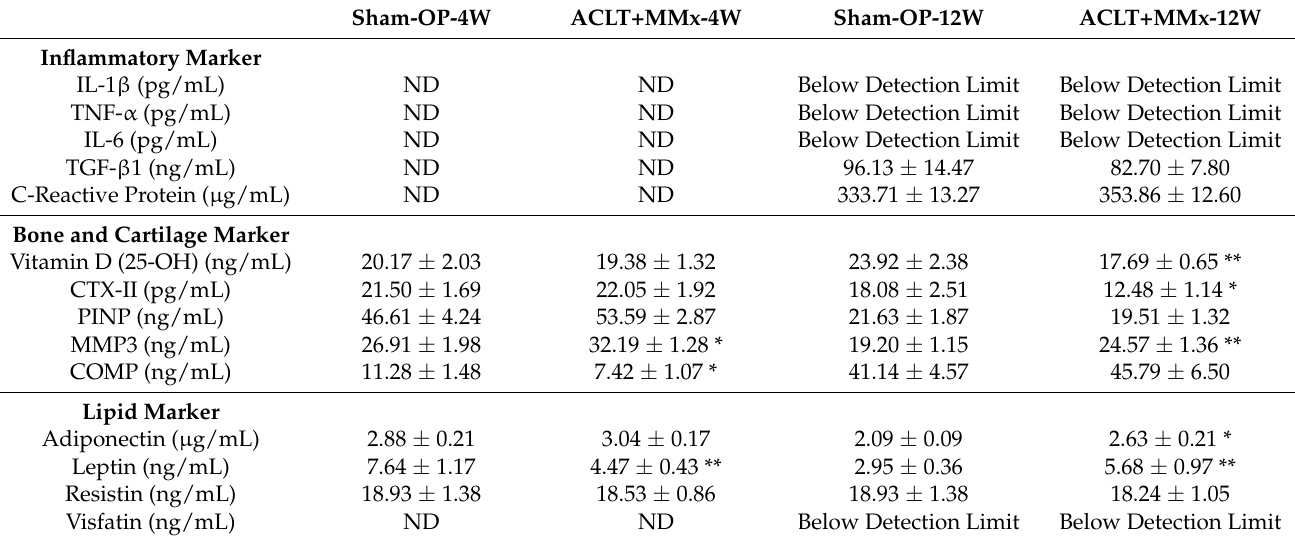
Table 2. Detection of the serological level of the biomarker at 4th and 12th weeks